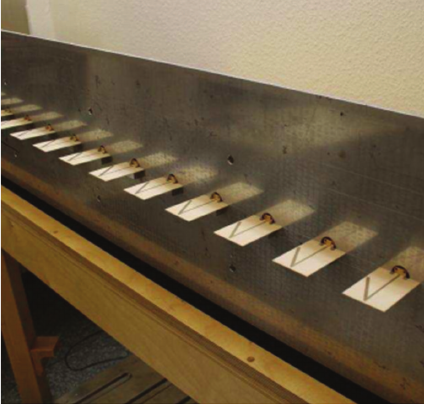
Figure 9: Picture of the receiving antenna array with rotatable antenna